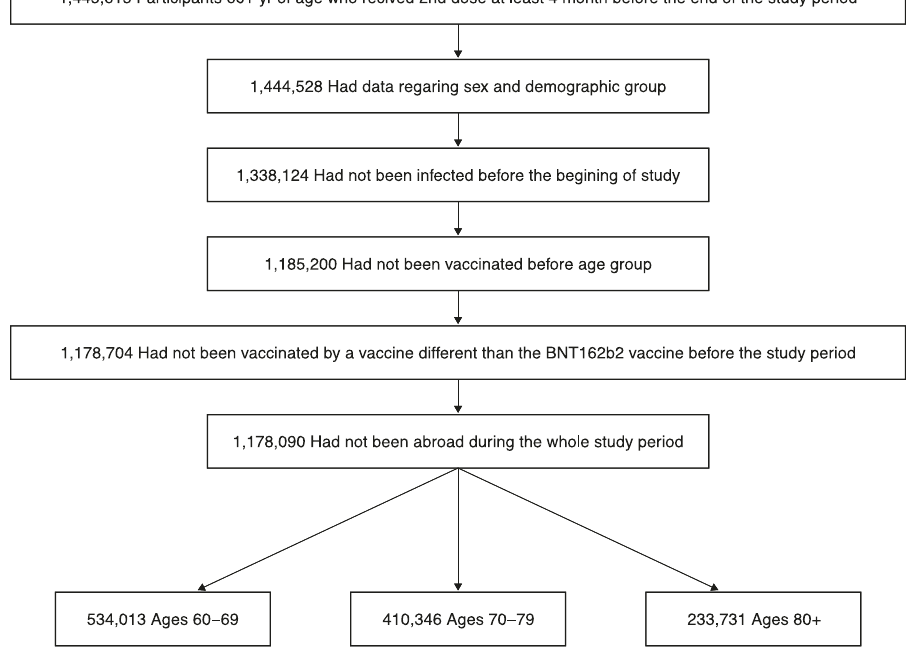
Fig. 2 Study population. The participants in the study included persons who were 60 years of age or older, who received 2nd dose at least 4 months before the end of the study, who were not infected by SARS-CoV-2 before the study period, had available data regarding sex and demographic sector, had not stayed abroad during the whole study period, and had not been vaccinated with a vaccine different from BNT162b2 before the study period.